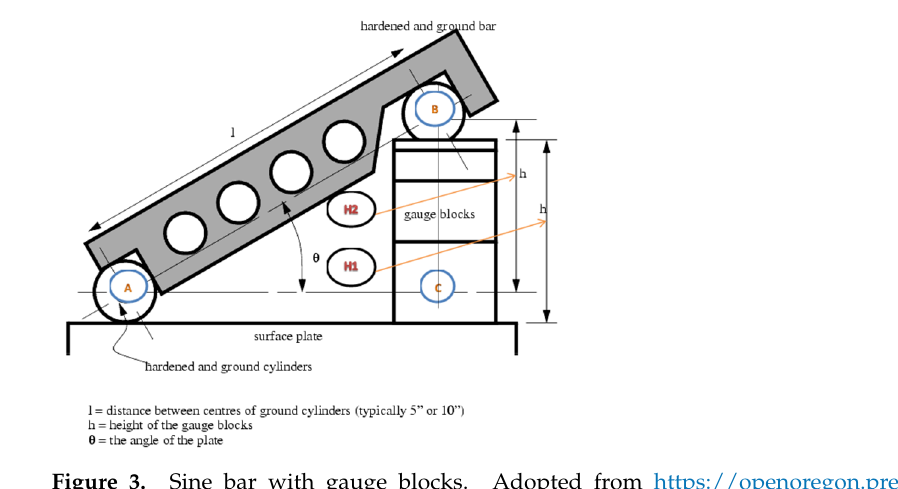
Figure 3. Sine bar with gauge blocks. Adopted from https://openoregon.pressbooks.pub/manufac-